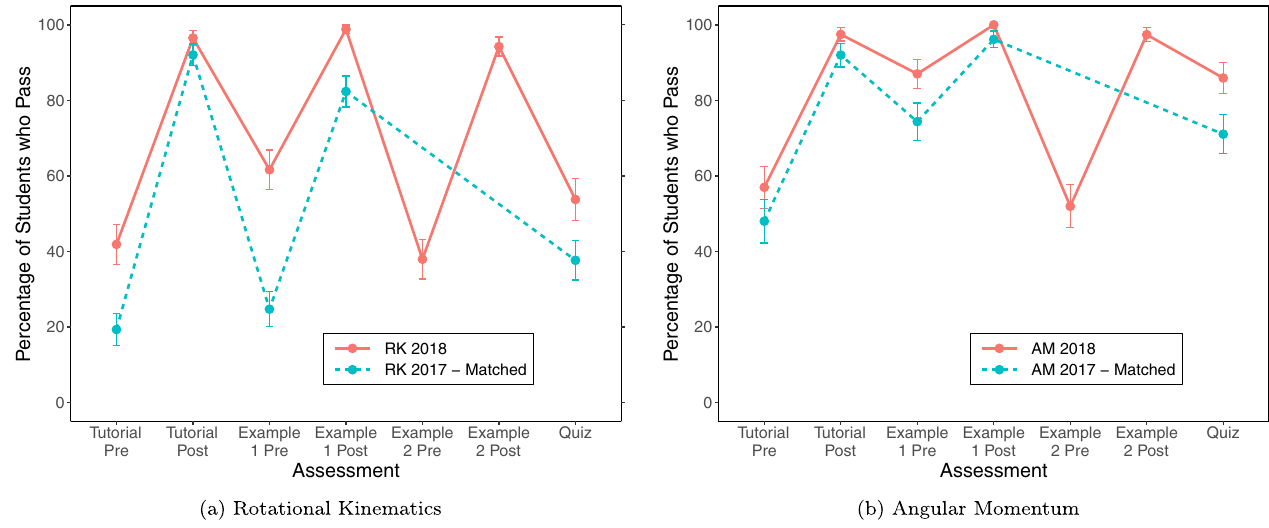
FIG. 4. Comparison of the performance on the pre and post attempts of module for students with 0 – 1 brief attempts. A subset of 2017 students were selected to match the background knowledge of 2018 students using a propensity score derived from exam scores. Passing rates on the on-ramp module is not shown. Data on example 2 from 2017 are absent because the module was added in 2018.